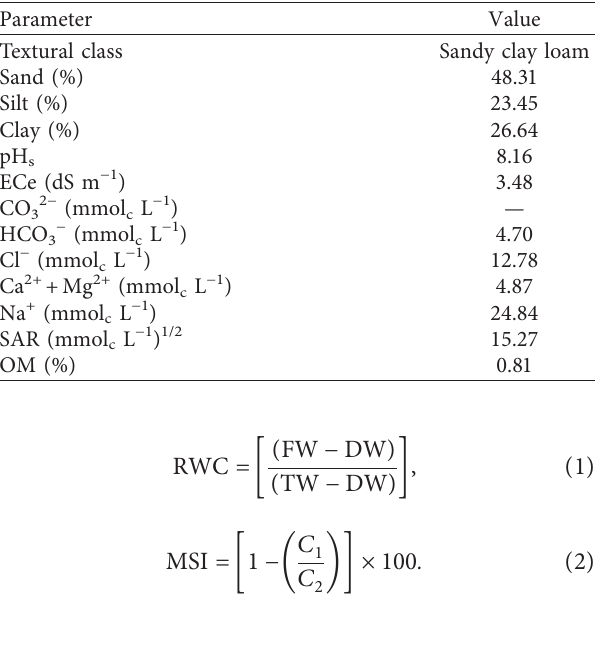
Table 1: Physicochemical properties of the tested